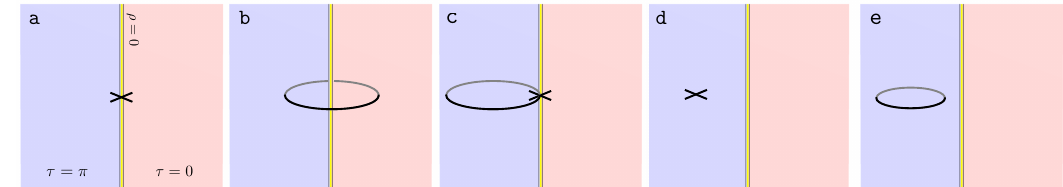
Figure 19 . Tree-level and one-loop contributions to log Z PI for massless vector field in Euclidean Rindler (E.28). These can be viewed as field theory limits of figure 18, with verbatim the same comments applicable to a - e . The worldline path integral c appears with a sign opposite to b in log Z (1) PI